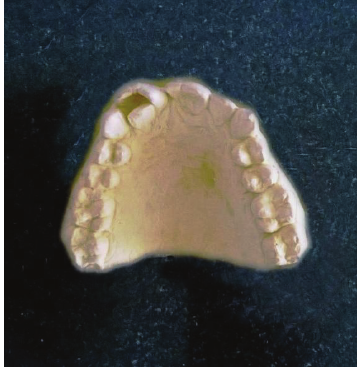
Figure 3: Study model.